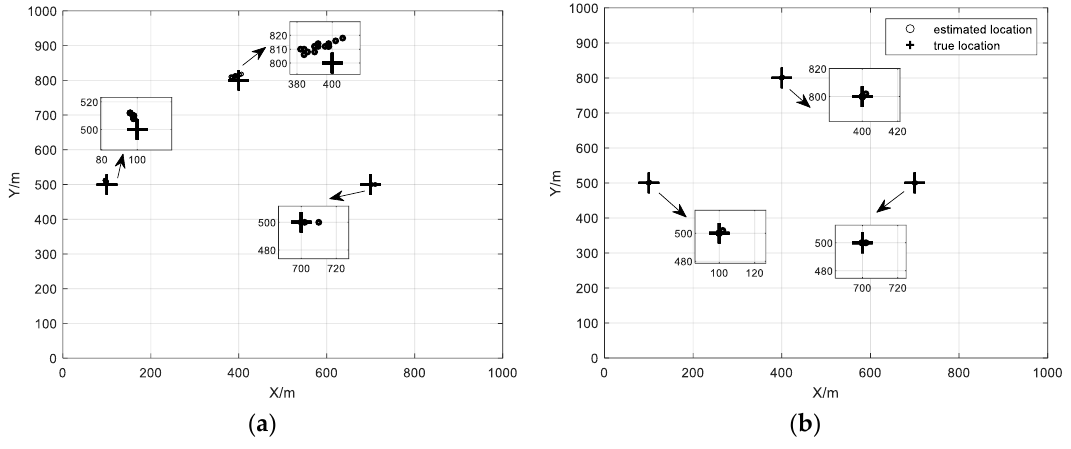
Figure 4. ( a ) Scatter plot without calibration; ( b ) scatter plot with the proposed